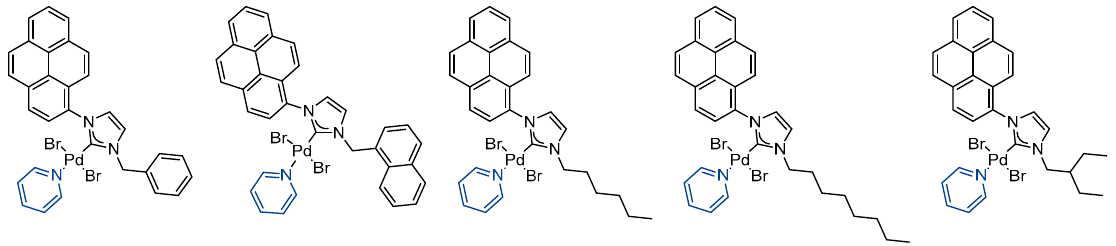
Figure 6. Pyrene based Pd-PEPPSI catalysts employed in the cross-coupling reactions.